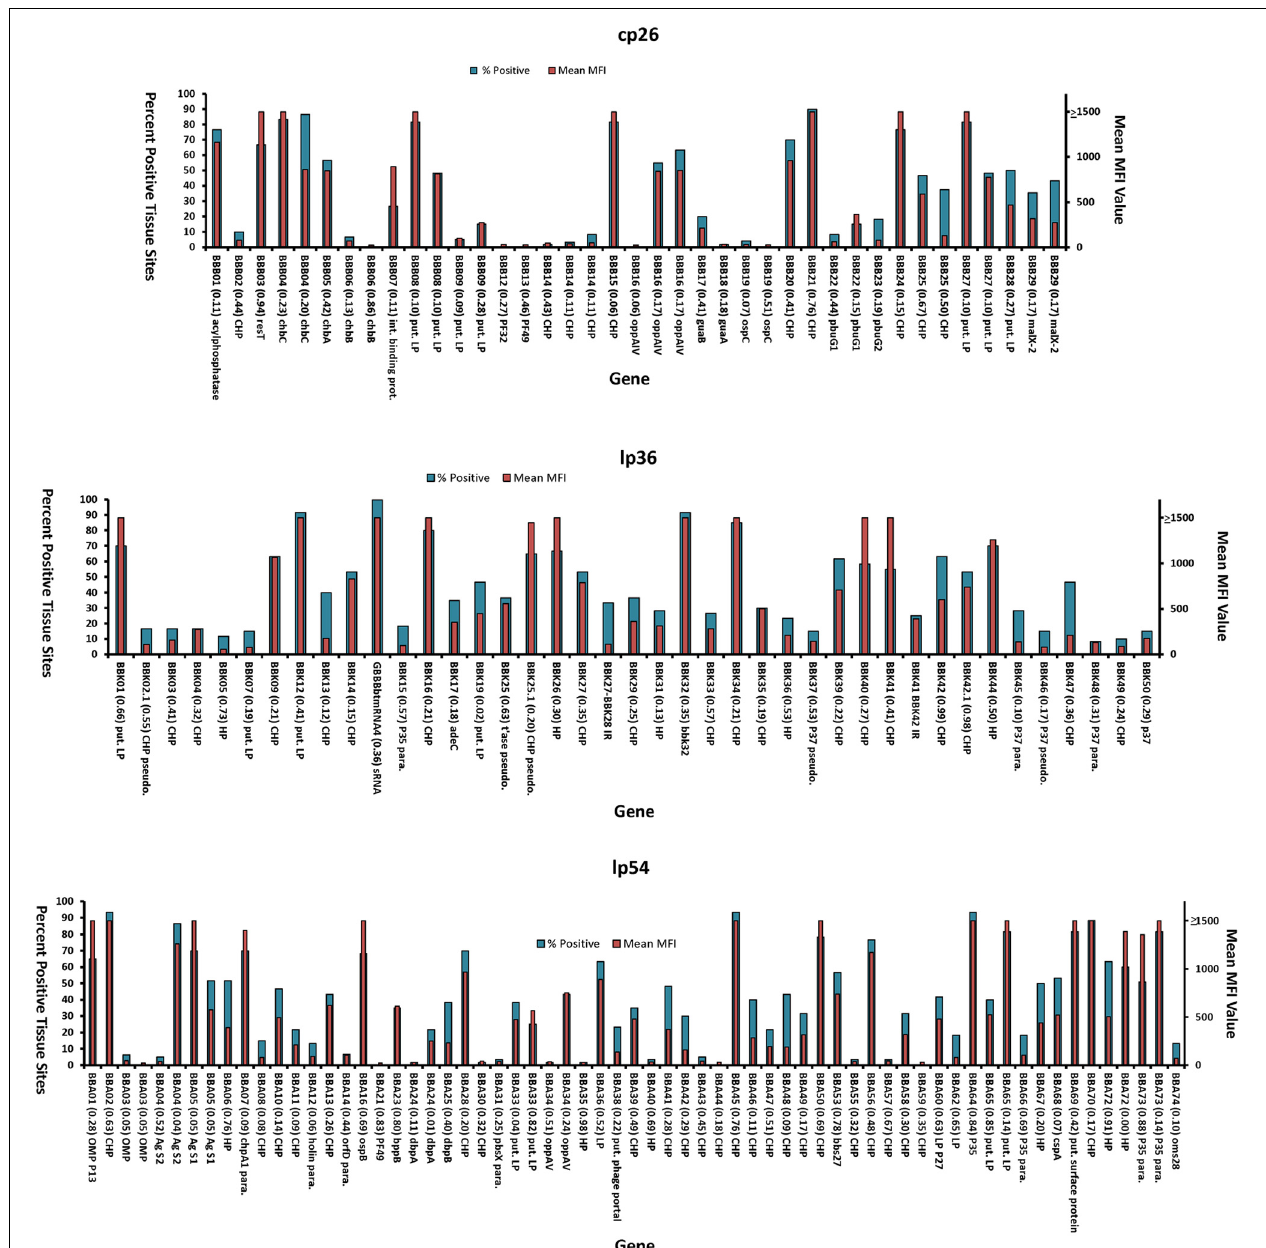
FIGURE 2 | Mouse infectivity of transposon mutants in plasmid-encoded genes, as determined by Luminex-based STM analysis. Results obtained for genes in plasmids cp26, lp36, and lp54 are shown. For each mutant, the data represent the percent of positive tissue sites (MFI > 100; blue bars) and mean MFI value (red bars) for 30–60 data points. Only clones that have all